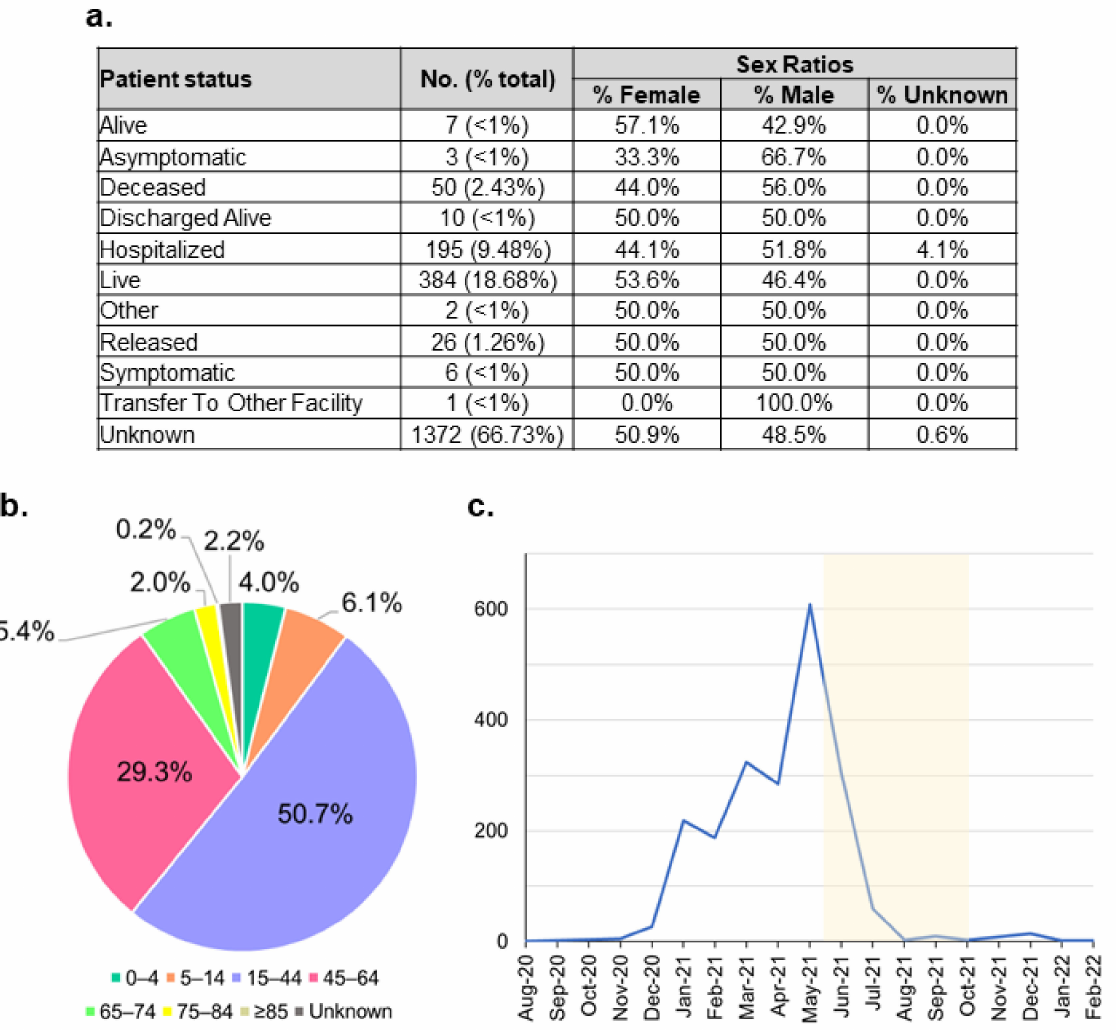
Figure 4. Indonesian B.1.466.2 variant metadata distribution. ( a ) Tabulation of patient status along with their sex ratios. ( b ) Age distribution shows that this variant mostly infected the productive age range of 15–64 years. ( c ) The variant case number peaked during April–May 2021, just before the outbreak of the Delta variant; highlighted in yellow is the Delta outbreak